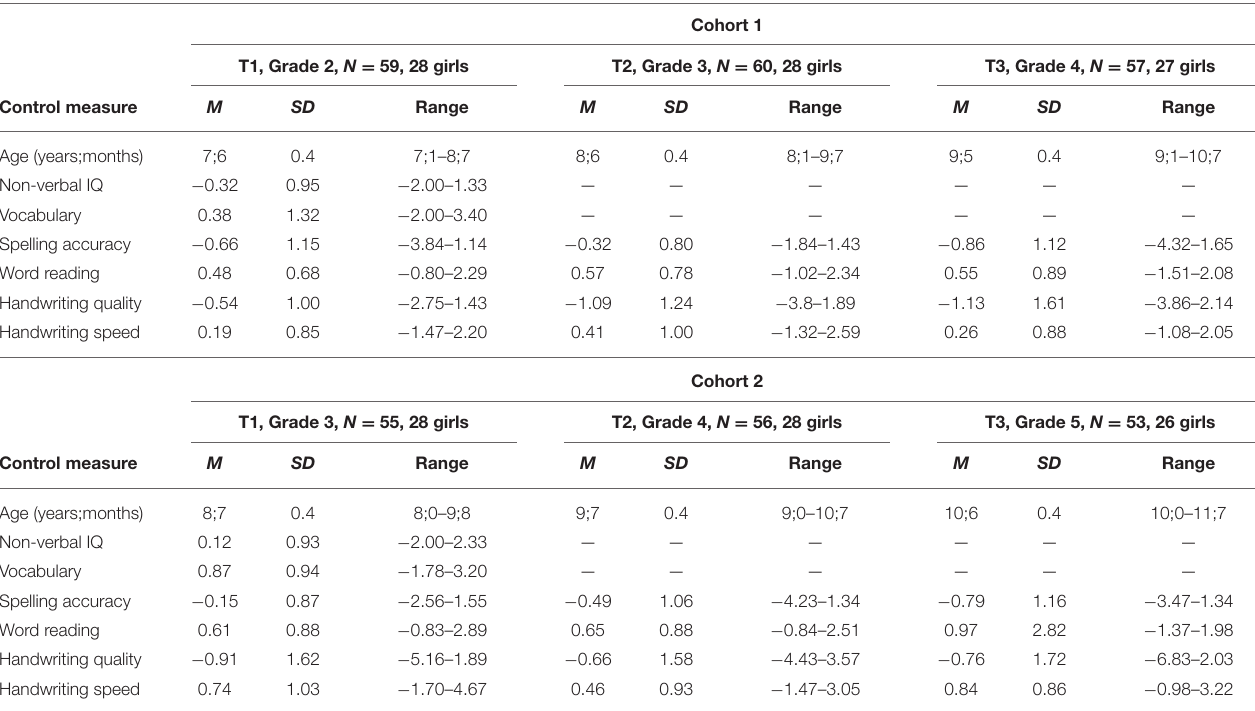
TABLE 1 | Children’s scores on control measures at each measurement